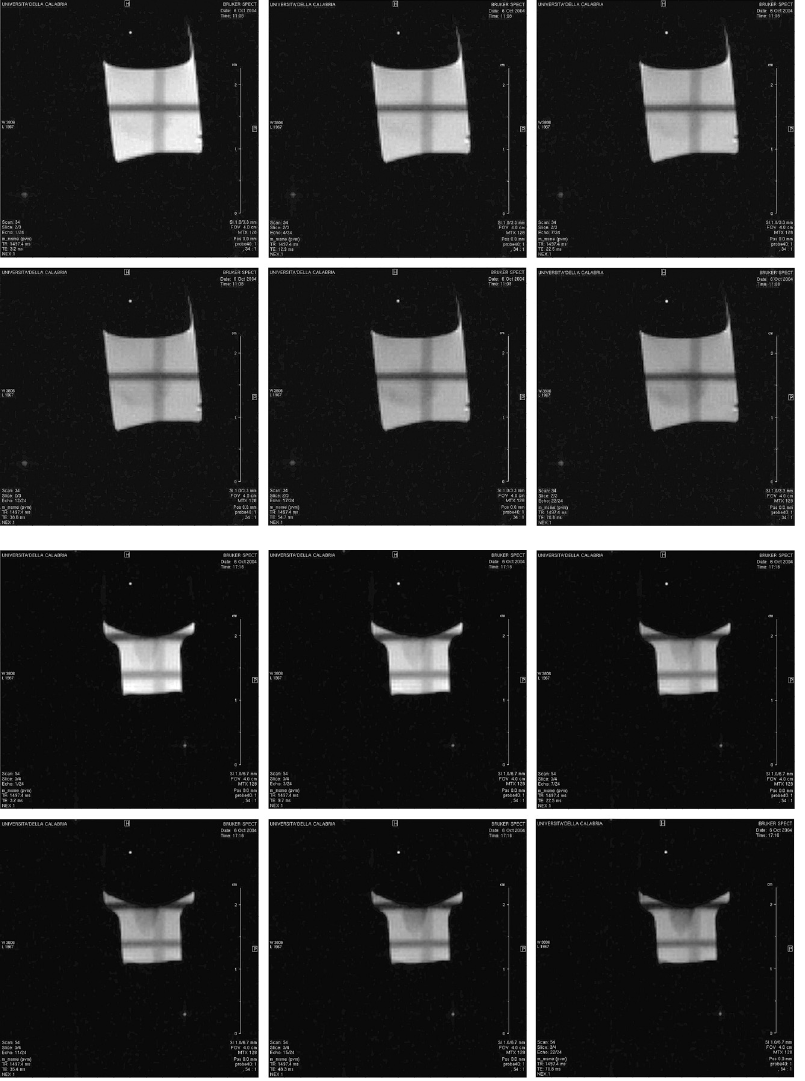
Figure 2 (right above): Flow curve built by overlap- ping data obtained by creep tests (square symbols) and step rate tests (circle sym- bols) for the sample at 15°C. the solid line connecting the experimental points is an eyes guide Figure 3 (left above): T weighted images for the 2 sample at rest at 15°C. Each image (T WIs) corre- T 2 2 sponds to different echo of the spin echo CPMG sequence 90 - (t - 180)n with t = 10 ms. The grey scale is proportional to the intensity of the signal. Figure 4 (left below): T weighted images for the 2 sample during a slow flow at 15 °C collected after 60 minutes from the initial